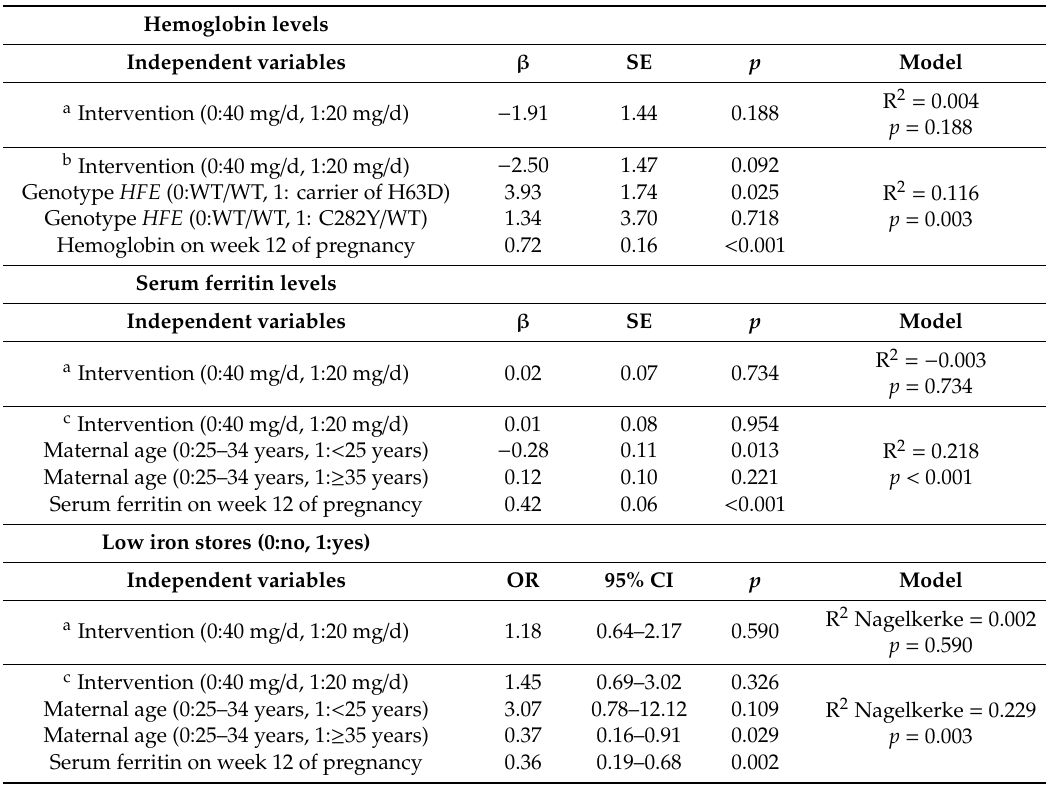
Table 5. The e ff ects of the intervention with iron supplementation (40 or 20 mg / day) throughout pregnancy on hemoglobin and serum ferritin levels and on the risk of ID, anemia, IDA, and hemoconcentration on the third trimester in women from Stratum